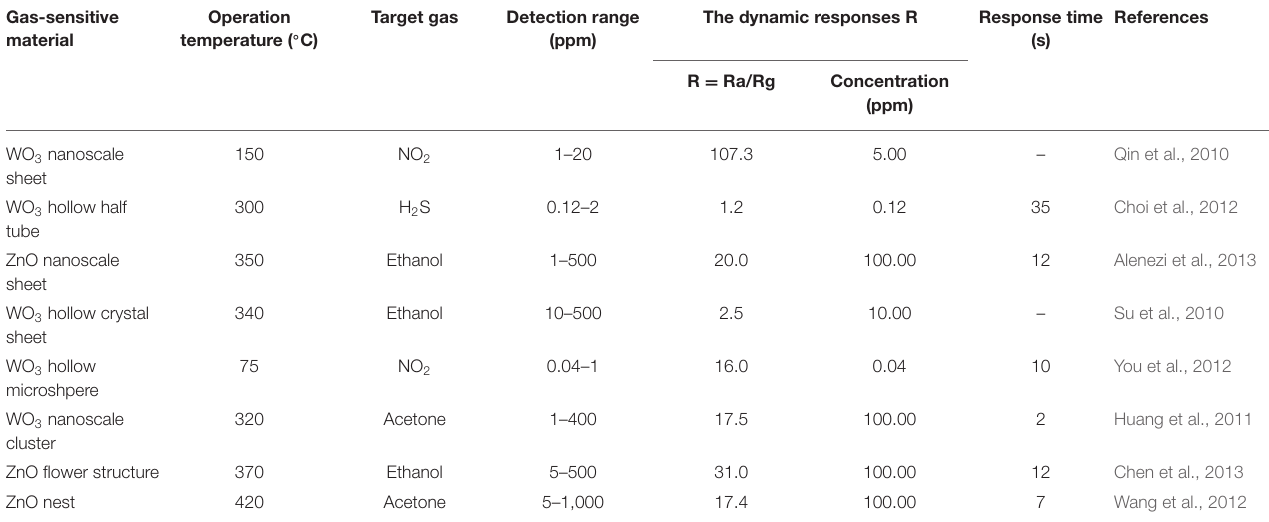
TABLE 1 | Relationship between microstructure, preparation, and gas sensitivity in 2-D nanomaterial (WO 3 , ZnO). Gas-sensitive